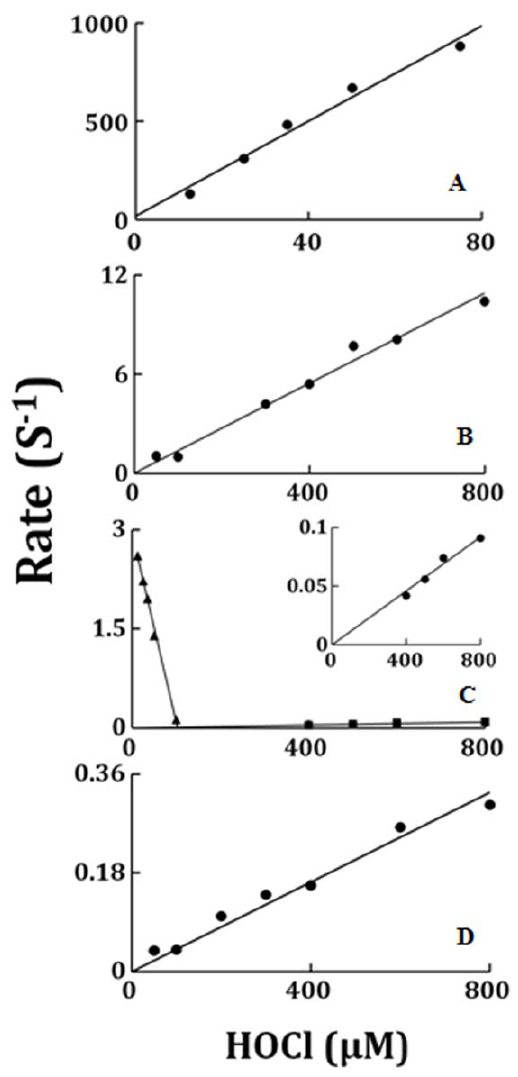
Figure 4. Plot of observed rate constants of various interme- diates that formed upon mixing of LPO-Fe(III) or LPO-Fe(II)-O 2 against increasing concentration of HOCl. The observed rates of LPO-Fe(III)-OCl formation monitored at 432 nm (Panel A); Compound II accumulation (Panel B); and Compound II decay(Panel C); as for Fig. 2, were plotted as a function of HOCl concentration. In Panel C, the close triangle represent kinetic parameters for Compound II decay to LPO- Fe(III), while the close circles represent kinetic parameters for Compound II destruction. The inset shows the rate of heme destruction, the curve was extrapolated to zero. Panel C is the plots of the observed rates for the LPO Compound III heme destruction versus HOCl concentration, monitored at 424 nm. The data are representative of three separate experiments.